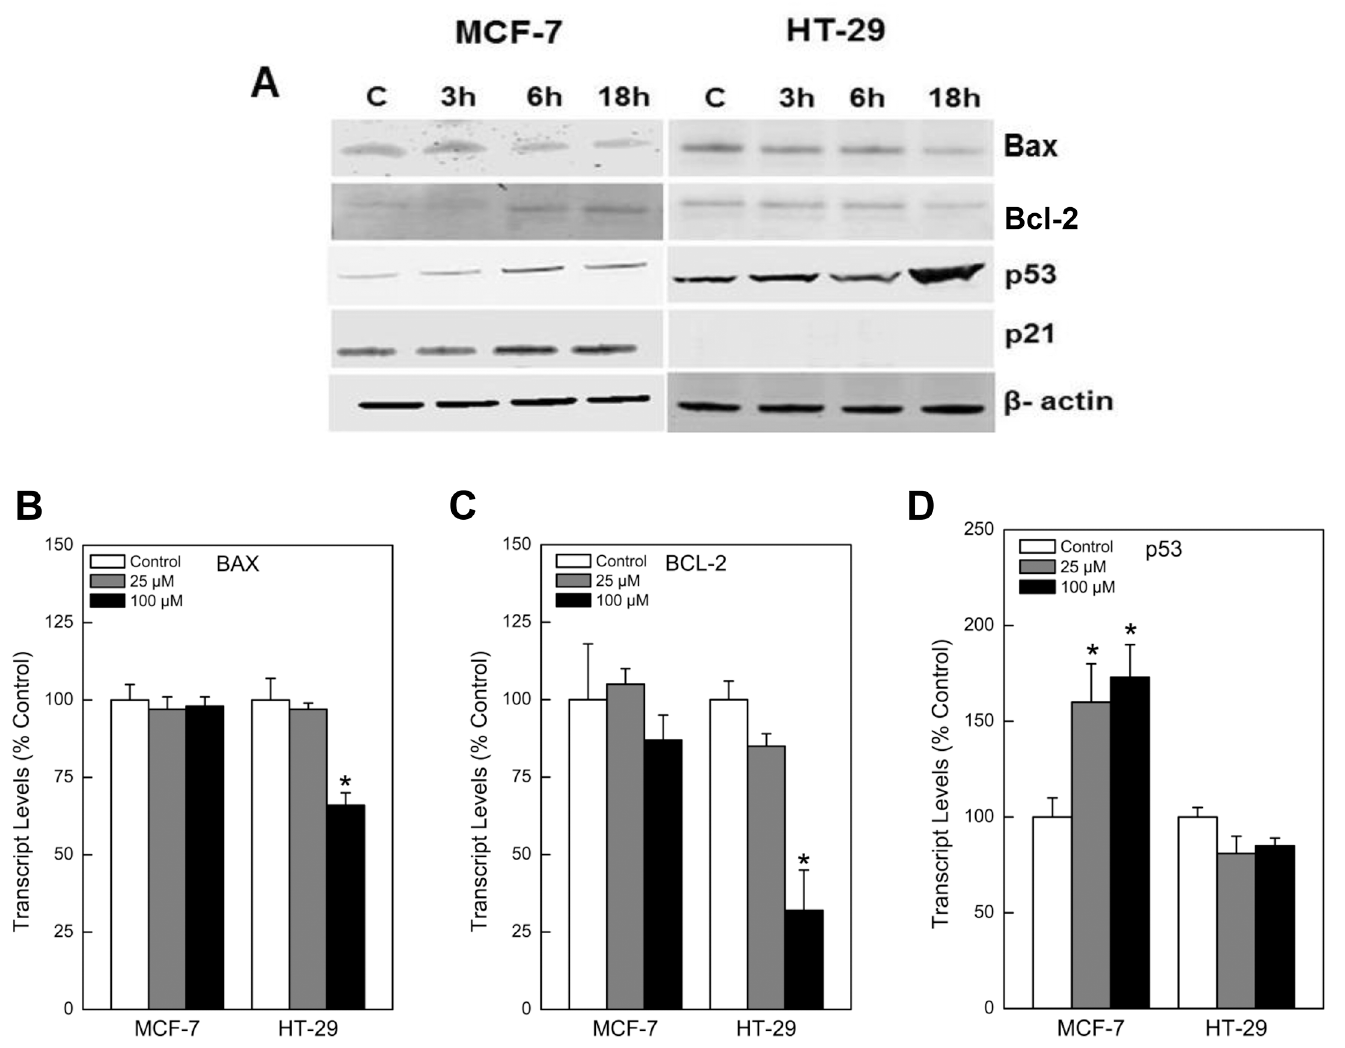
Fig 5. (A) Western blot analysis for Bax, bcl2, p53 and p21 proteins in MCF-7 and HT-29 cells following treatment with PPNO (100 μ M) for various times. (B) Transcript levels for Bax, (C) bcl2, and (D) p53 genes following treatment with various concentrations of PPNO. The Western and the RT-PCR analysis were carried out as detailed in the Methods